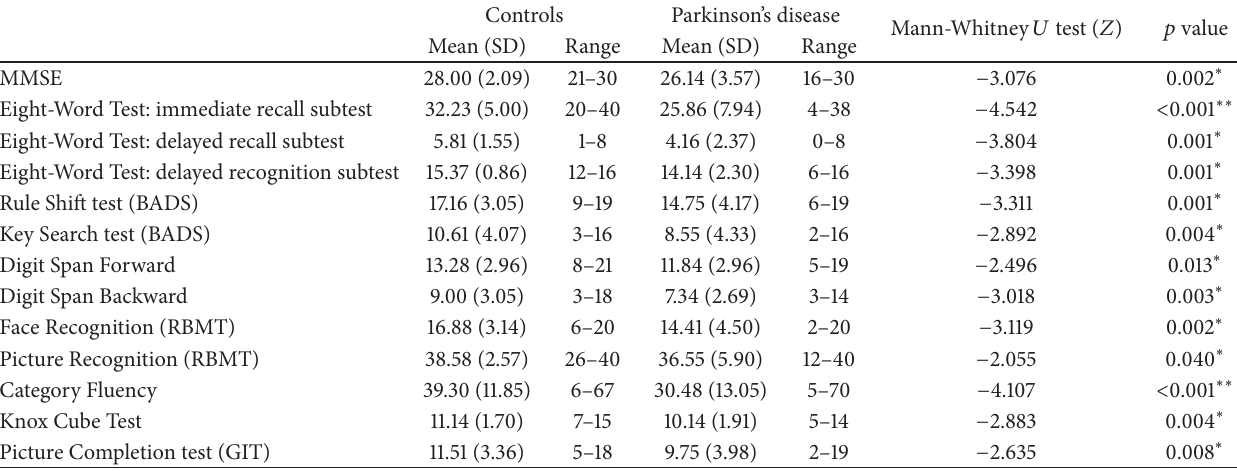
Table 2: Cognitive performance in PD patients and controls. SD: standard deviation; MMSE: Mini-Mental State Examination;